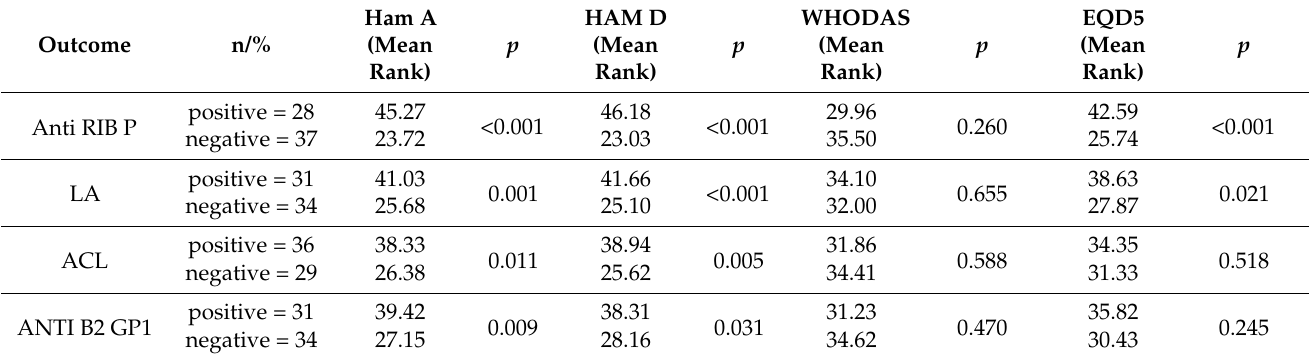
Table 4. Differences of anxiety, depression and quality of life based on the analyzed